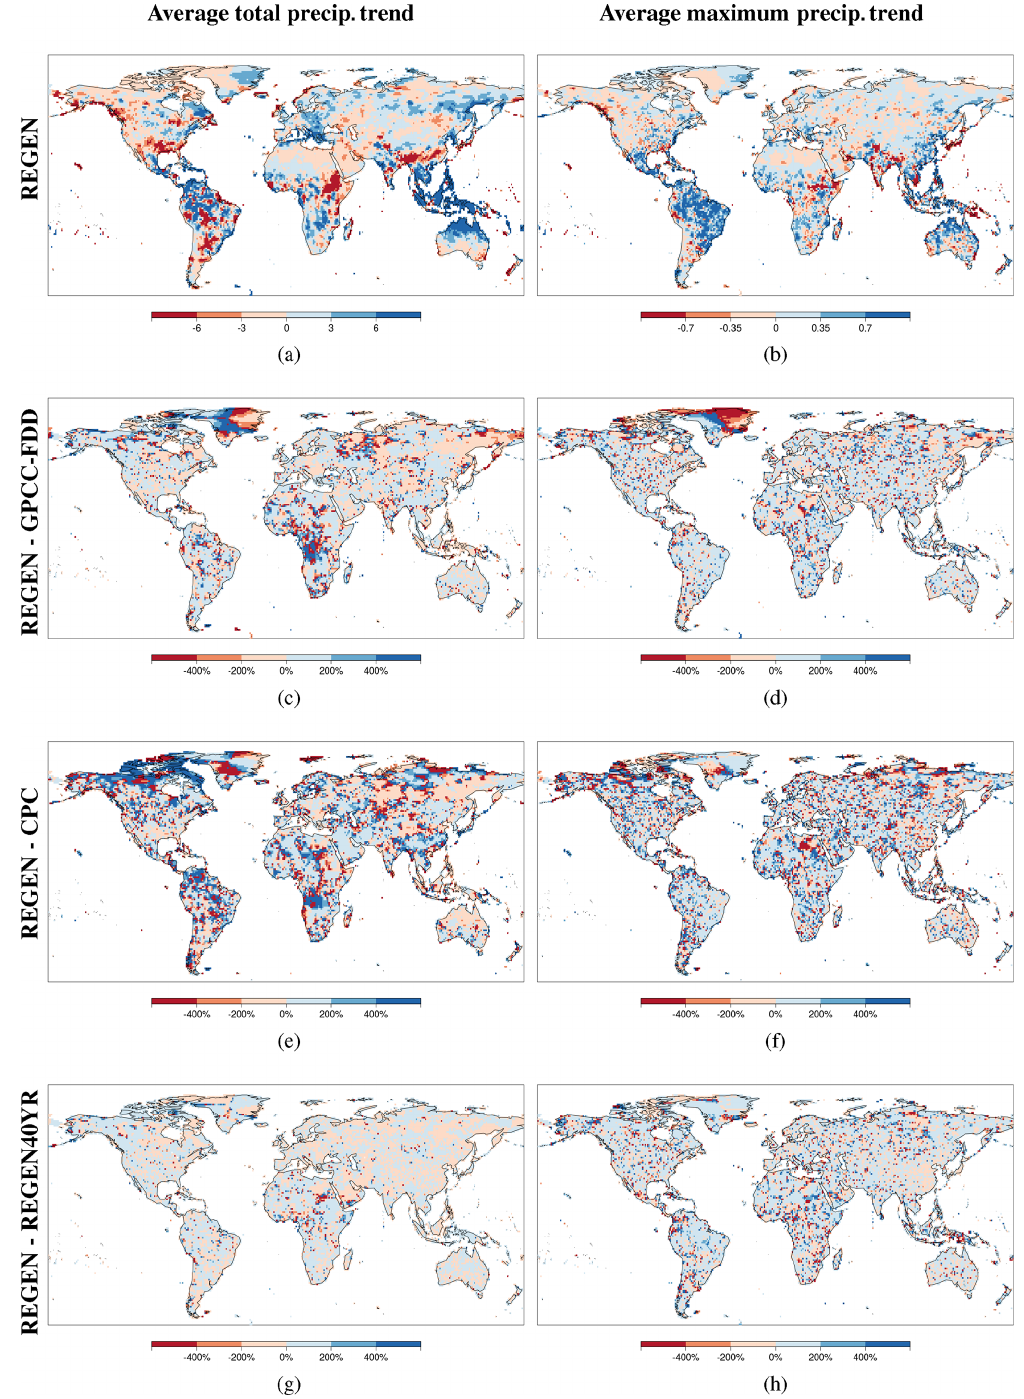
Figure 11. Percentage difference in total annual precipitation trends (c, e, g) , and annual maximum precipitation trends (d, f, h) between REGEN and GPCC (c, d) , REGEN and CPC (e, f) , and REGEN and REGEN40YR (g, h) data. The first column shows the absolute values of total annual precipitation trends (a) and annual maximum precipitation trends (b) averaged over 1988–2013 (the longest common time period between the three